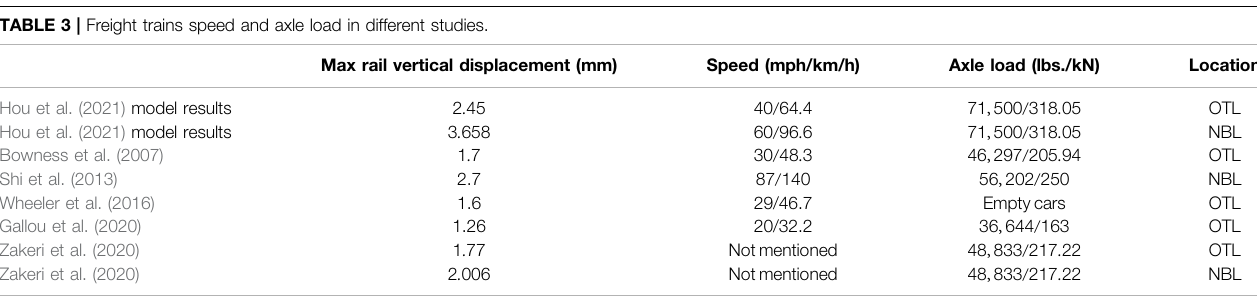
TABLE 3 | Freight trains speed and axle load in different